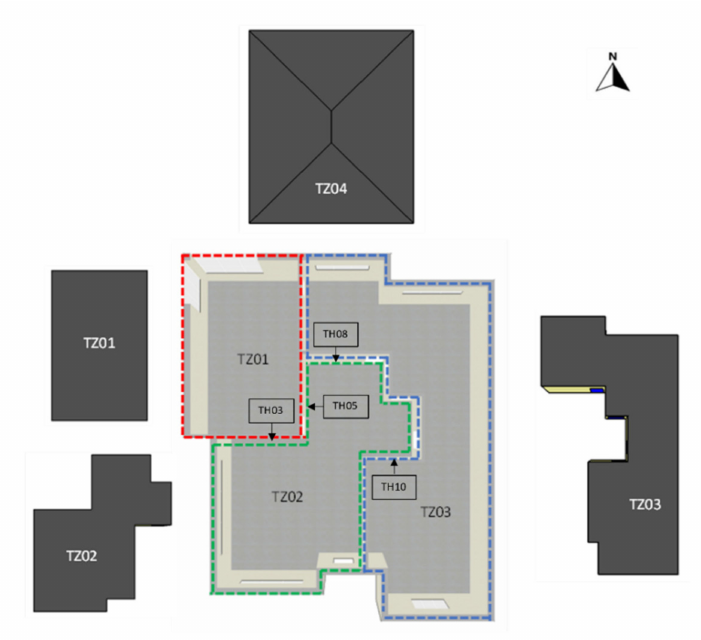
Figure 7. Layout of the indoor thermal zones (TZ01, TZ02 and TZ03) and positioning of the monitor- ing sensors (TH03, TH05, TH08 and TH10).